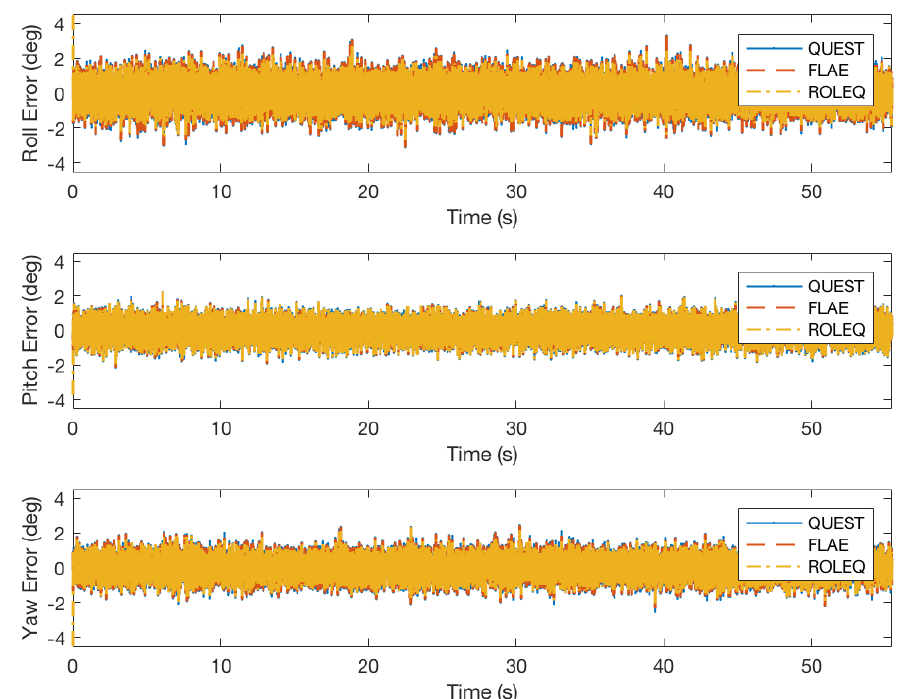
Figure 5. Experiment results of Recursive OLEQ (ROLEQ) and representative algorithms using sampled data and different